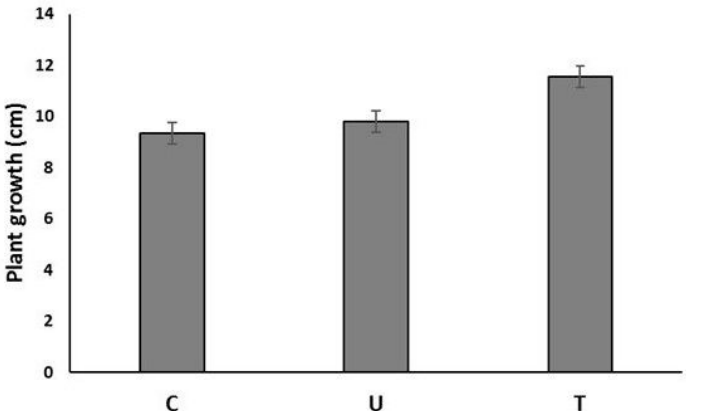
Figure 5. Influence of the managements (Uncultivated: U, Control: C, and Treated: T) on plant growth. Bars indicate mean ± standard error.